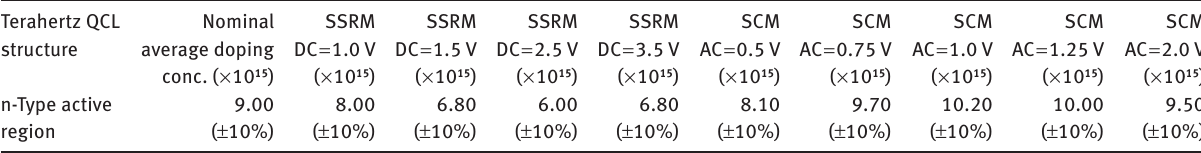
Table 2: Comparison of average doping concentrations derived from calibrated SSRM and SCM measurements, and the average designed doping concentration values of the active region of the terahertz QCL device for different DC and AC bias voltages, respectively. Terahertz QCL